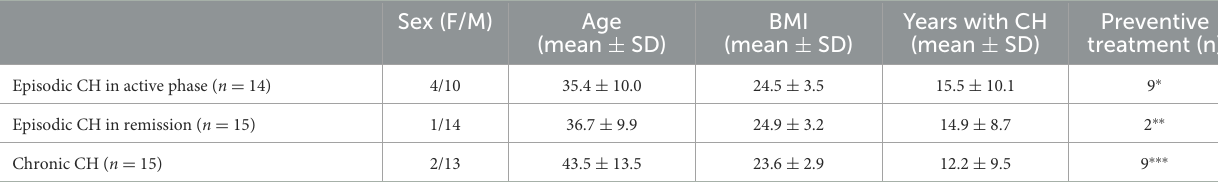
TABLE 1 Clinical characteristics of enrolled